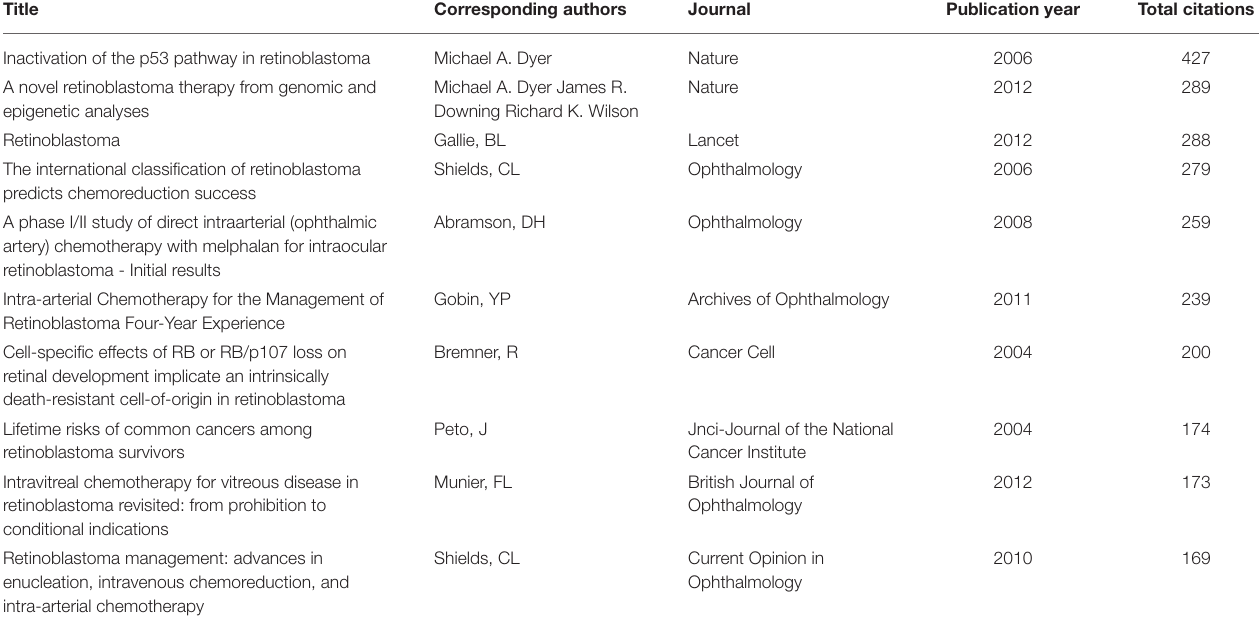
TABLE 2 | Top 10 publications with the most citations in retinoblastoma